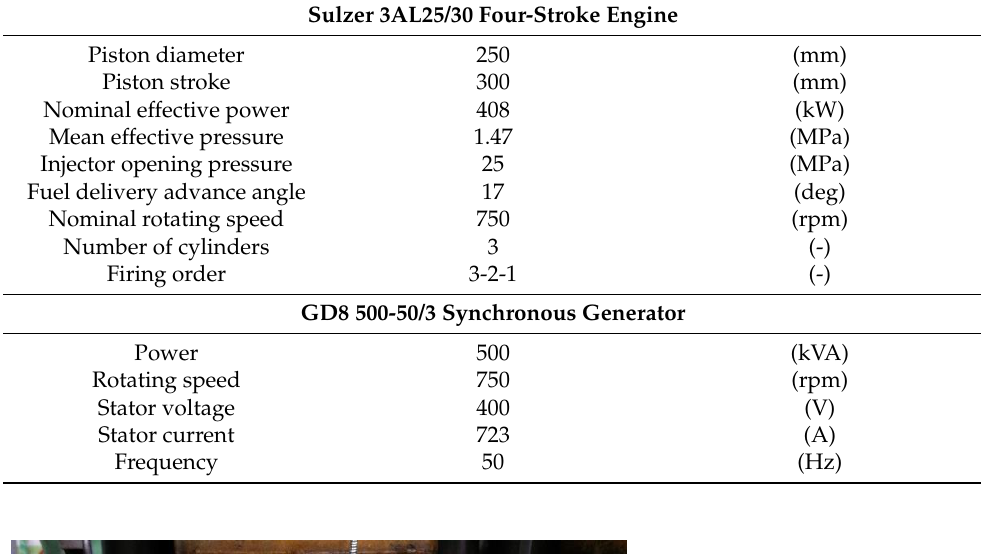
Table 1. Test-stand technical and nominal parameters.